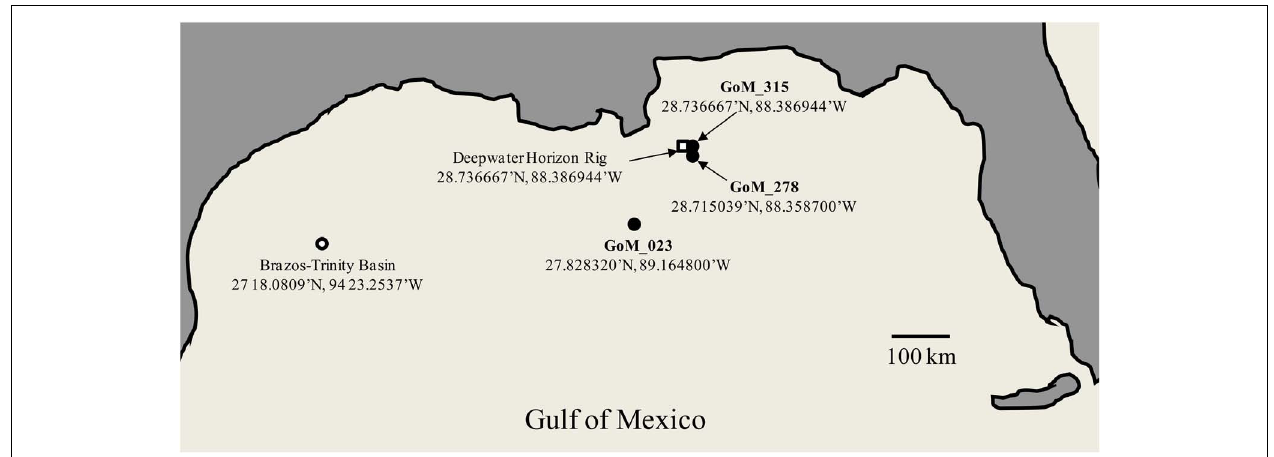
FIGURE 1 | Map of the Gulf of Mexico sampling sites. Open square – DWH rig; filled circle – sampling sites from the current study; open circle – BT Basin sampling site from Biddle etal. (2011).The Peru Margin (PM) sampling sites used for comparison are described in Biddle etal.